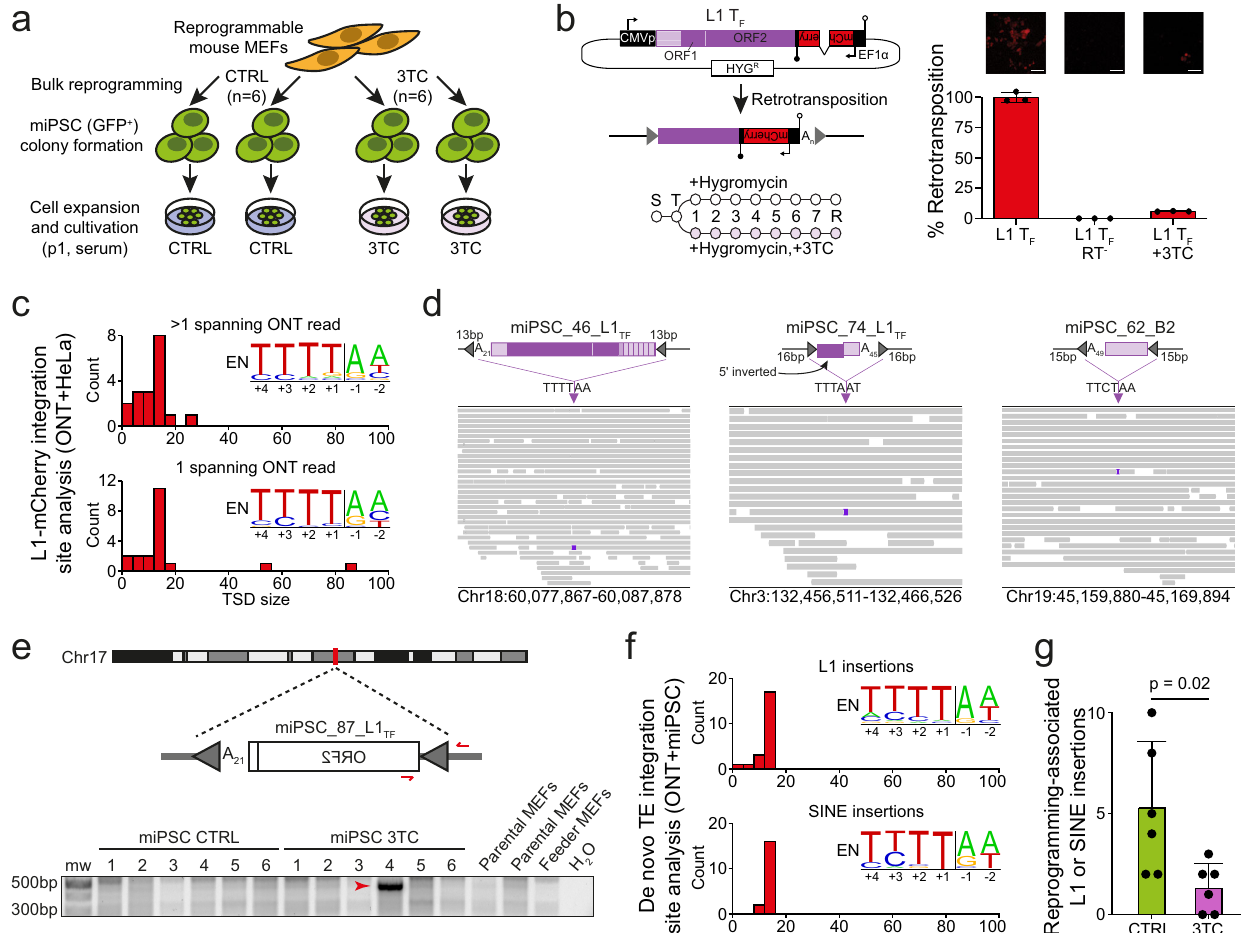
Fig. 3 | Long-read detection of retrotransposition in HeLa cells and MEF- retrotransposition events recovered from HeLa cells via TLDR analysis of ONT derived bulk miPSC lines. a Bulk MEFs were reprogrammed by the addition of sequencing, divided into integrants detected by >1 (top) or 1 (bottom) spanning read. Inset sequence logos 120 display the observed integration site motif, as pre- doxycycline. Oct4 -GFP positive miPSCs were then sorted and expanded in serum. ferred by the L1 endonuclease (EN). d Integrative genomics viewer (IGV) 121 inspec- Six miPSC lines were reprogrammed and cultured in media containing 100 µ M tion of 3 example de novo TE insertions. Cartoons (top) show a full-length (>6 lamivudine (3TC), and six miPSC lines generated without lamivudine (CTRL). DNA monomers) L1 T F insertion, a heavily 5 ′ truncated L1 T F insertion, and a SINE B2 was extracted from MEFs and miPSCs and then ONT sequenced. b Top left: ret- insertion,each fl ankedbyTSDs(graytriangles)anda3 ′ polyAtract,andintegrated rotransposition indicator plasmid L1-mCherry consists of the pCEP4 backbone at the indicated L1 EN motif. IGV snapshots (bottom) show ONT read alignments (CMV promoter, black; SV40 polyadenylation signal, open lollipop; hygromycin from the miPSC line carrying each TE insertion (purple box). e A 5 ′ truncated resistance gene HYG R , white) containing a wild-type L1 T F element (5 ′ UTR, light purple; ORFs, dark purple). An mCherry reporter gene equipped with an EF1 α intergenic de novo L1T F insertion. PolyA (A n ) tractlength isindicated immediately 3 ′ oftheL1.PCRvalidationprimersareshownasredarrows.Underneathisshowna promoterandHSVtkpolyadenylationsignal(blacklollipop)isinsertedintotheL13 ′ PCRvalidationagarosegelcontainingthe5 ′ junctionPCRproduct(redarrow)only UTRantisensetotheL1.ThemCherrysequenceisinterruptedbyanintroninsense in the miPSCline where the L1 was detected by ONT sequencing. Molecularweight orientation relative to the L1, ensuring mCherry expression only upon retro- (mw) markersareprovided atthe leftof the gel.Note: DNA wasobtainedfrom two transposition. bottom left: retrotransposition assay timeline. Cells were split (S), parentalMEFaliquots,onecorrespondingtomiPSCCTRL/3TClines1 – 3andoneto transfected (T), and cultured in hygromycin-containing medium with and without miPSC CTRL/3TC lines 4 – 6. f TSD size distributions for de novo L1 (top) and SINE 100 µ M 3TC. Retrotransposition ef fi ciency was assessed by fl ow cytometry 8 days (bottom) insertions detected in miPSC lines via ONT sequencing, with inset inte- post-transfection (R). top right: fl uorescence microscopy images showing repre- gration site sequence logo, as per ( c ). g Putative reprogramming-associated L1- sentative wells at 8 days post-transfection with L1 T F (left), reverse transcriptase mutant (RT - ) L1 T F (middle), and L1 T F treated with 100 µ M 3TC (right). Scale bars mediated insertion counts detected by ONT sequencing in CTRL and 3TC-treated (white) represent 100 µ m. bottom right: Retrotransposition ef fi ciency assessed by miPSCs. Replicate ( n =6 per group) data points are marked by black dots and fl ow cytometry, relative to L1 T represented as the mean±SD. Signi fi cance was calculated via a two-tailed t test. F . Histogram depicts the mean±SD of three inde- pendent biological replicates (black dots, n =3) consisting of three technical Source data are provided as a Source Data fi replicates each. c Target site duplication (TSD) size distributions for L1-mCherry